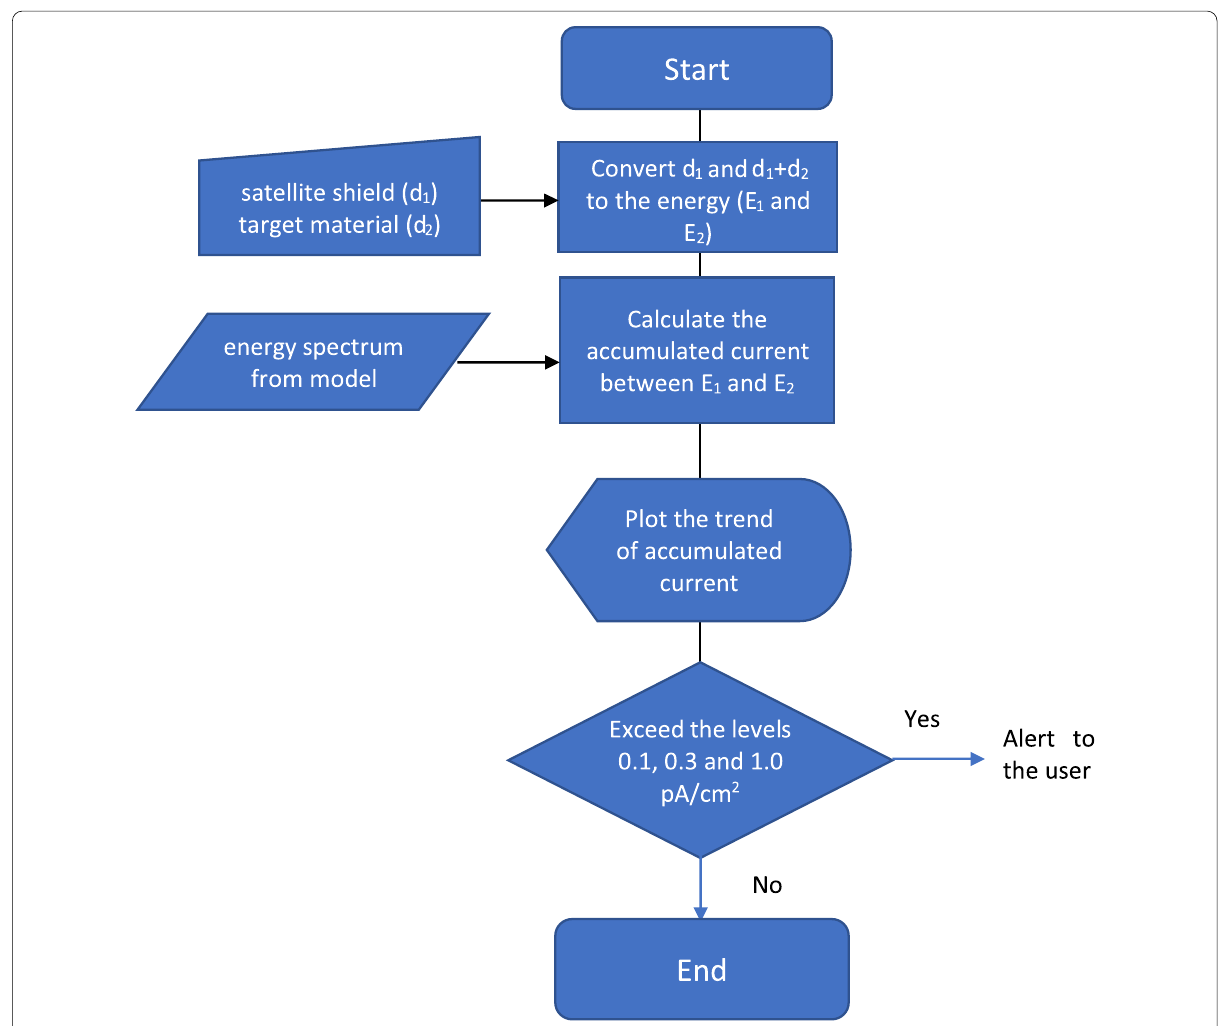
Fig. 10 Flowchart of the alert system of internal